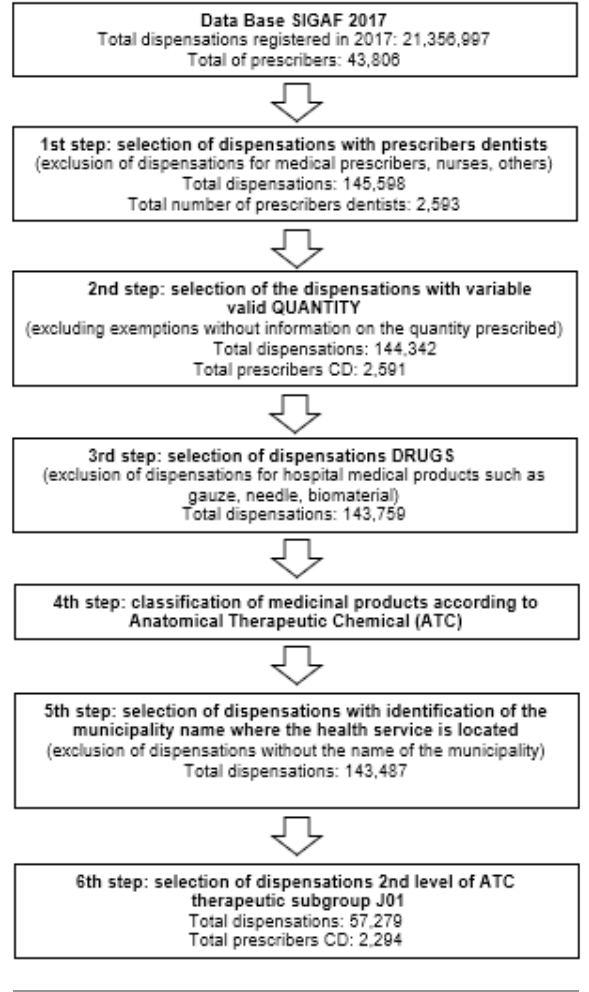
Figure 1. Flowchart of data extraction from SIGAF/SES-MG databank,